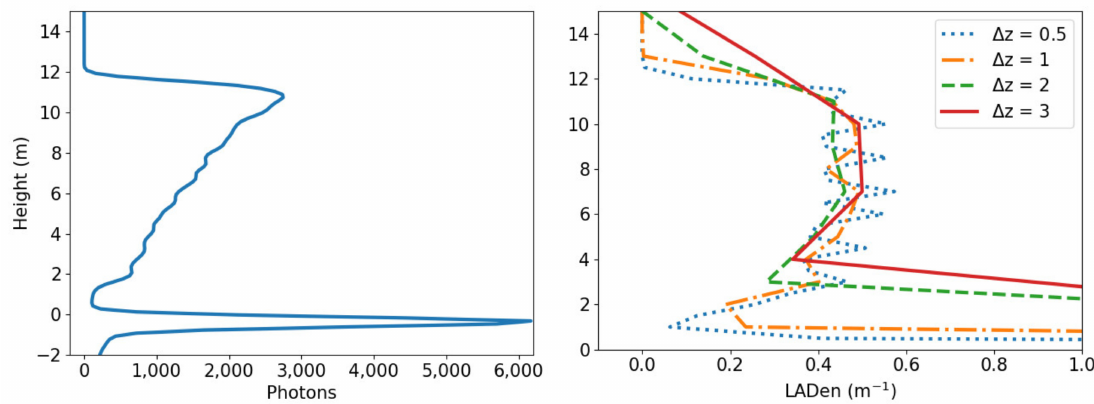
Figure 9. Lidar waveform, seen on the left, and the LADen profiles estimated using the waveform intensity data on the